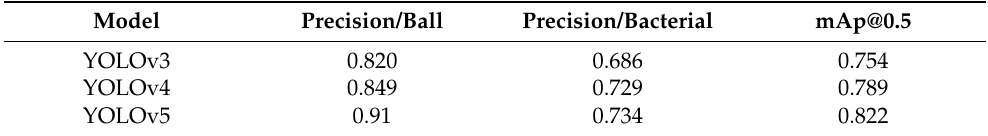
Table 1. The results of the comparison of YOLOv3, YOLOv4, and YOLOv5 detection algorithms.